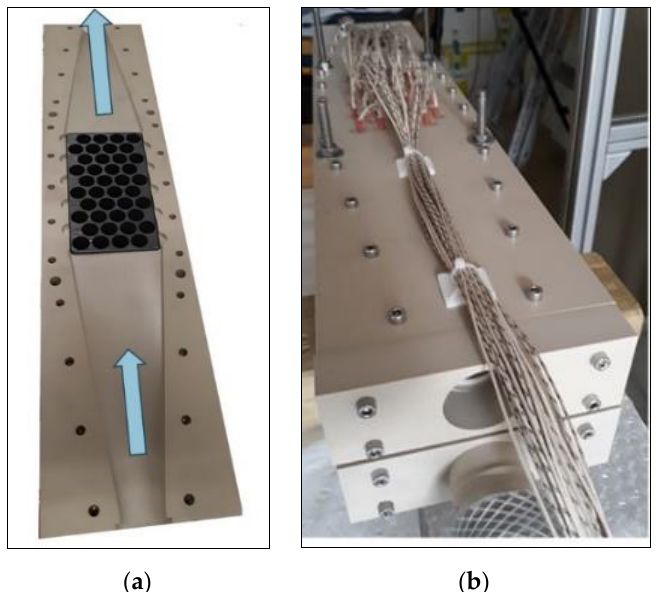
Figure 10. ( a ) Cooling air channel at the top of the mockup, ( b ) battery pack mockup and cabling of the instrumentation.